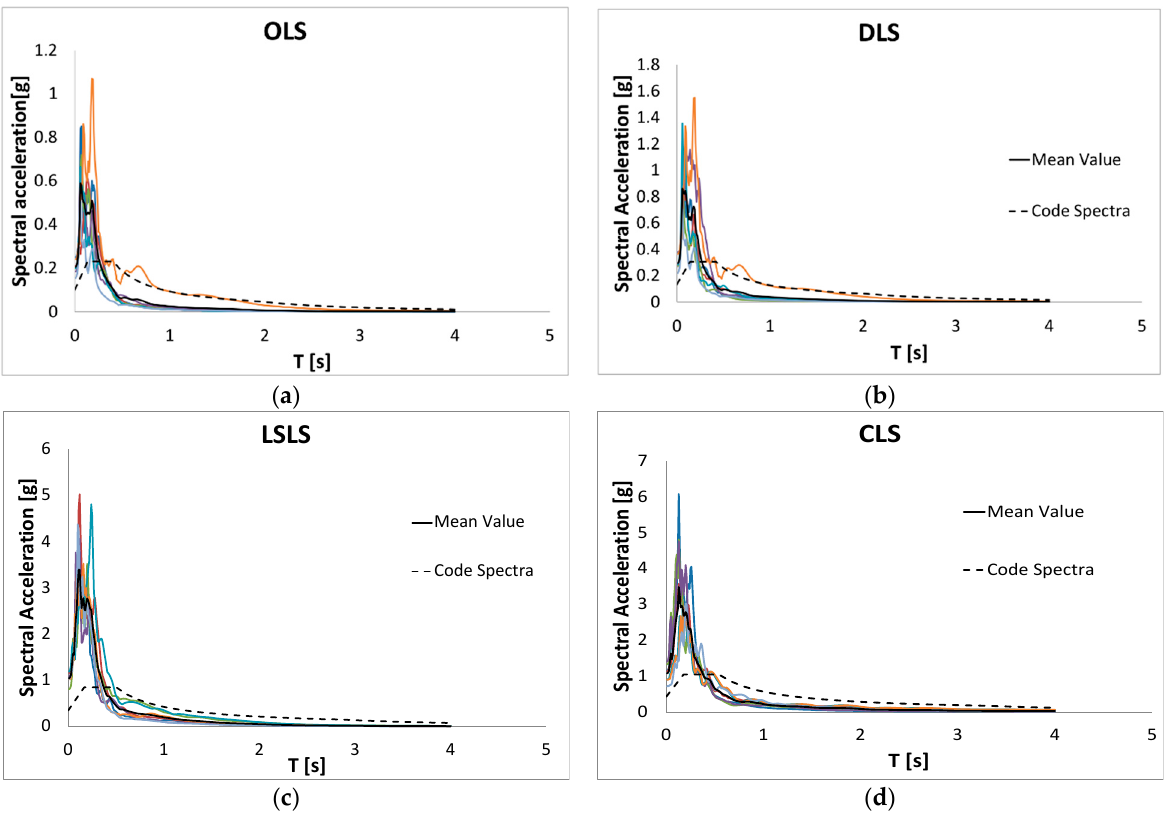
Figure 15. Scales spectra for the site of Reggio Calabria, Mean spectra and code spectra for a soil type B, with evidence of ( a ) Operational Limit State (OLS), ( b ) Damage Limit State (DLS), ( c ) Life-Safety Limit State (LSLS) and ( d ) Collapse Limit State (CLS).